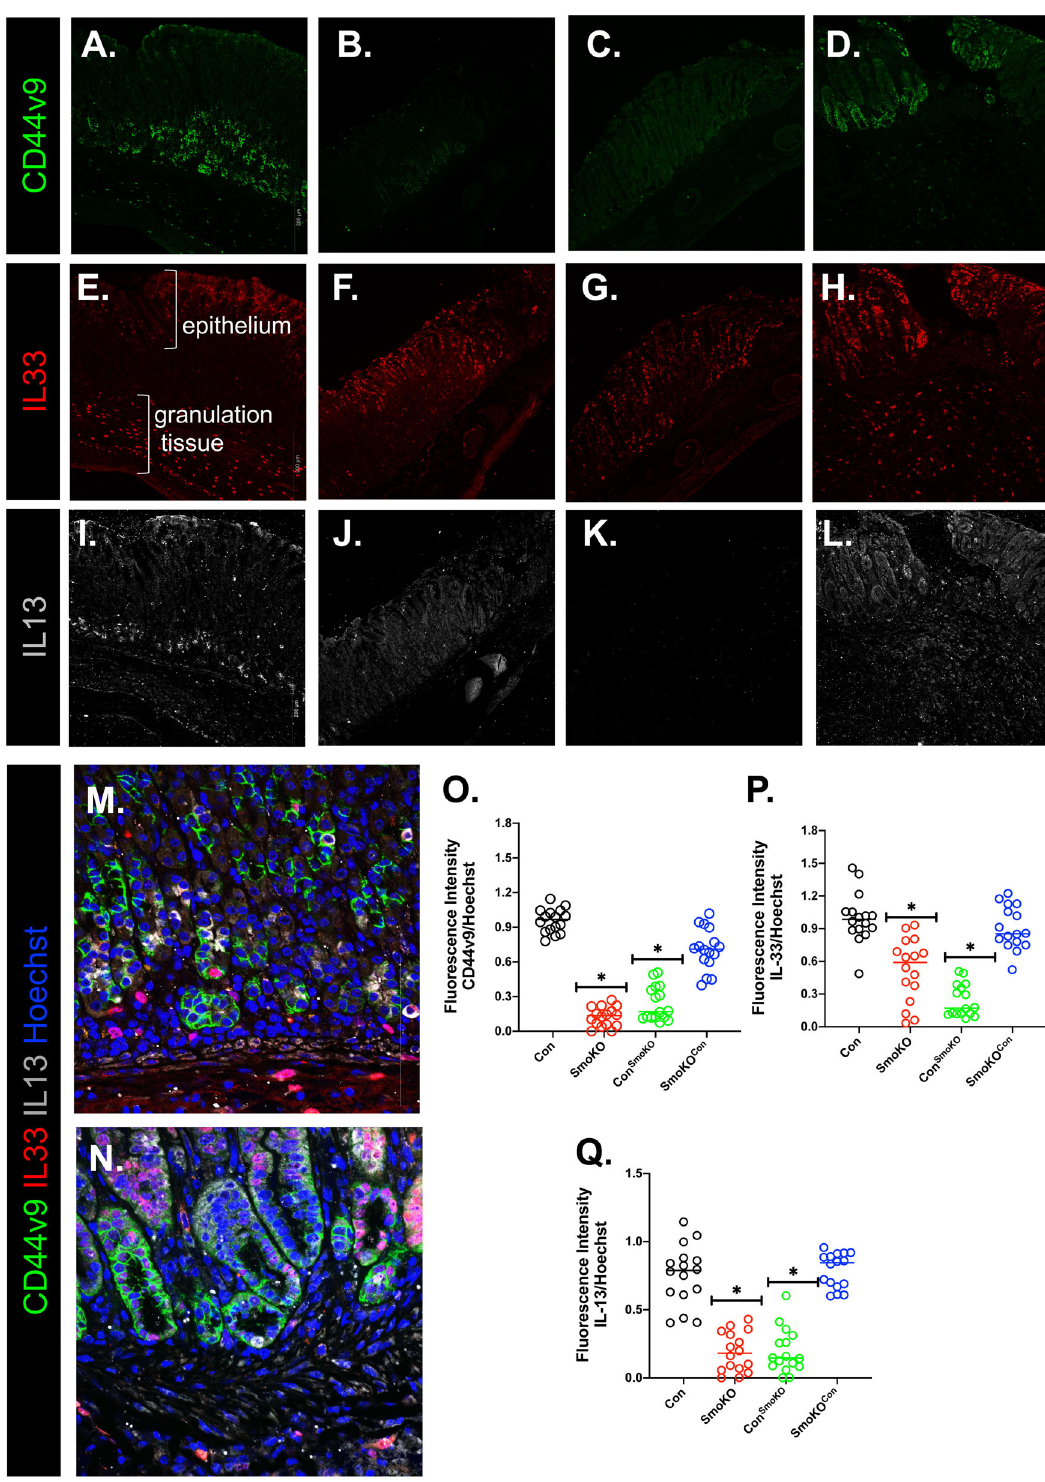
Fig. 3 Expression of CD44v9, IL33, and IL13 within the stomachs of control and LysMCre/SmoKO mice. Representative immuno fl uorescence staining using antibodies speci fi c for CD44v9 (green), IL33 (red), and IL13 (gray) in the stomachs of A , E , I control, B, F , J SmoKO, C , G , K Control SmoKO , and D , H , L LysMCre/SmoKO con mice. Representative immuno fl uorescence staining using antibodies speci fi c for CD44v9 (green), IL33 (red), and IL13 (gray) in the stomachs of M control and N LysMCre/SmoKO con mice. Quanti fi cation of fl uorescence intensity of O CD44v9, P IL33, and Q IL13 in mouse experimental groups. * P < 0.05 compared to control group, n = 6 mice per group. Data are shown as the mean ±